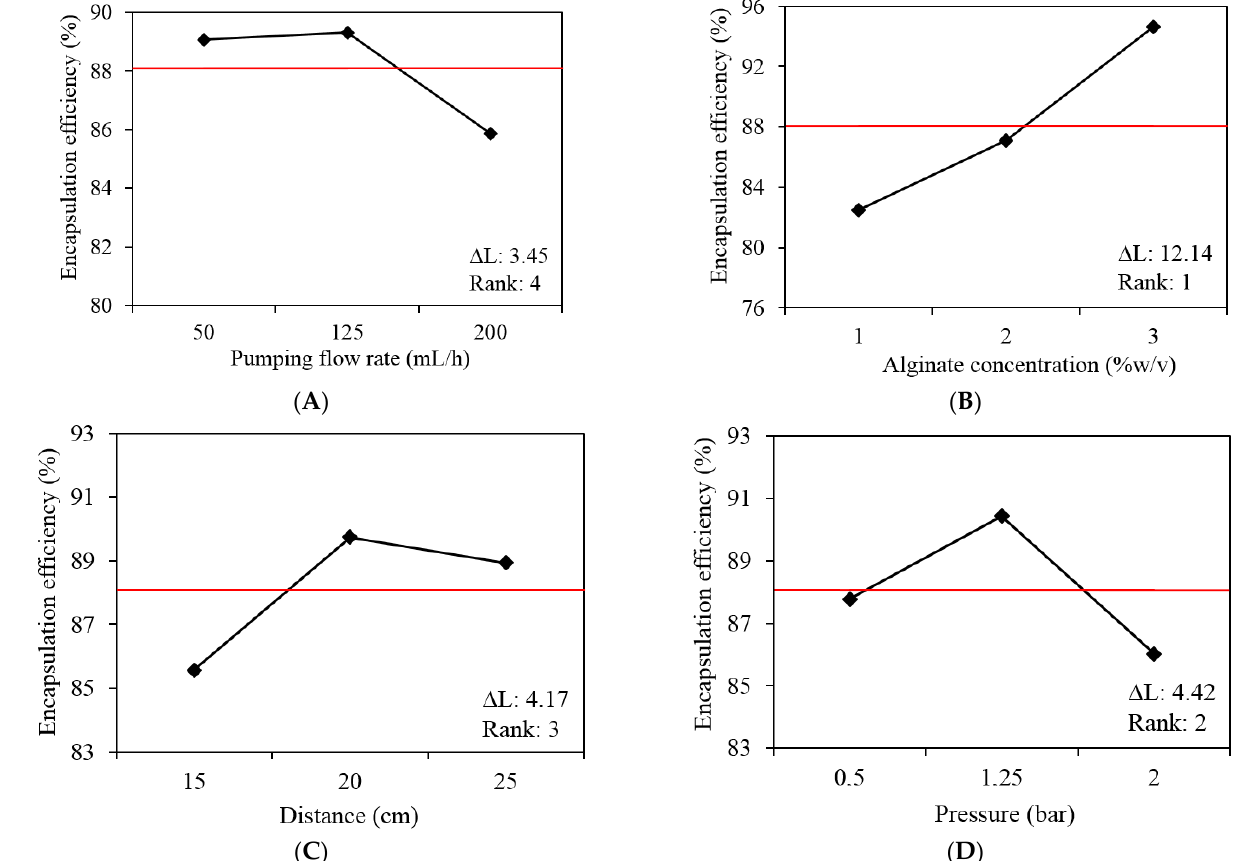
Figure 3. The effect of each variable working level on the antigen encapsulation efficiency. ( A ) Pump- ing flow rate, ( B ) Alginate concentration, ( C ) Distance and ( D ) Pressure. The red line represents the total average responses of experimental runs, ∆ L corresponds to the size of the effect by taking the difference between the highest and lowest characteristic average for a factor, Rank represents the order of the variables from those with the largest effect to the